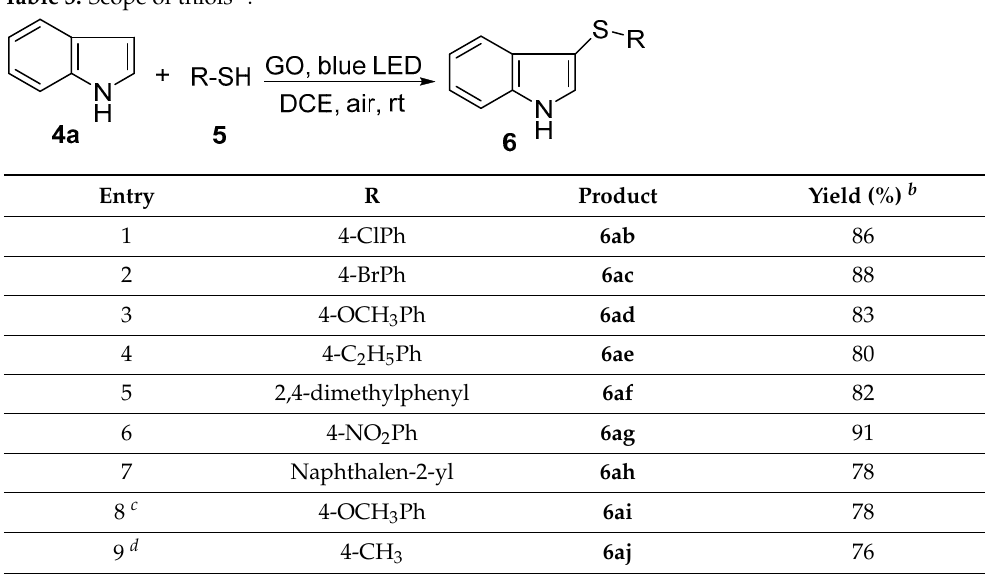
Table 3. Scope of thiols a